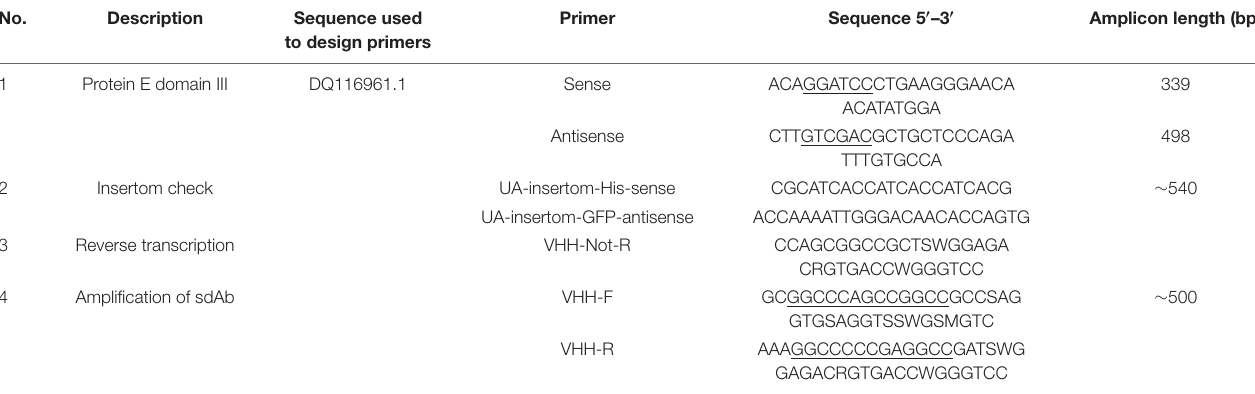
TABLE 1 | List of